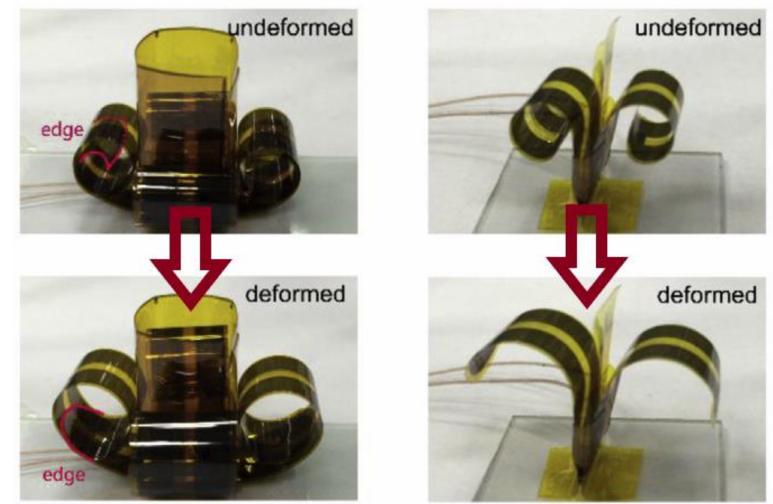
Figure 8. Electromechanical deformation of the actuators upon applying bias voltage [169]. Copyright Elsevier (2018).